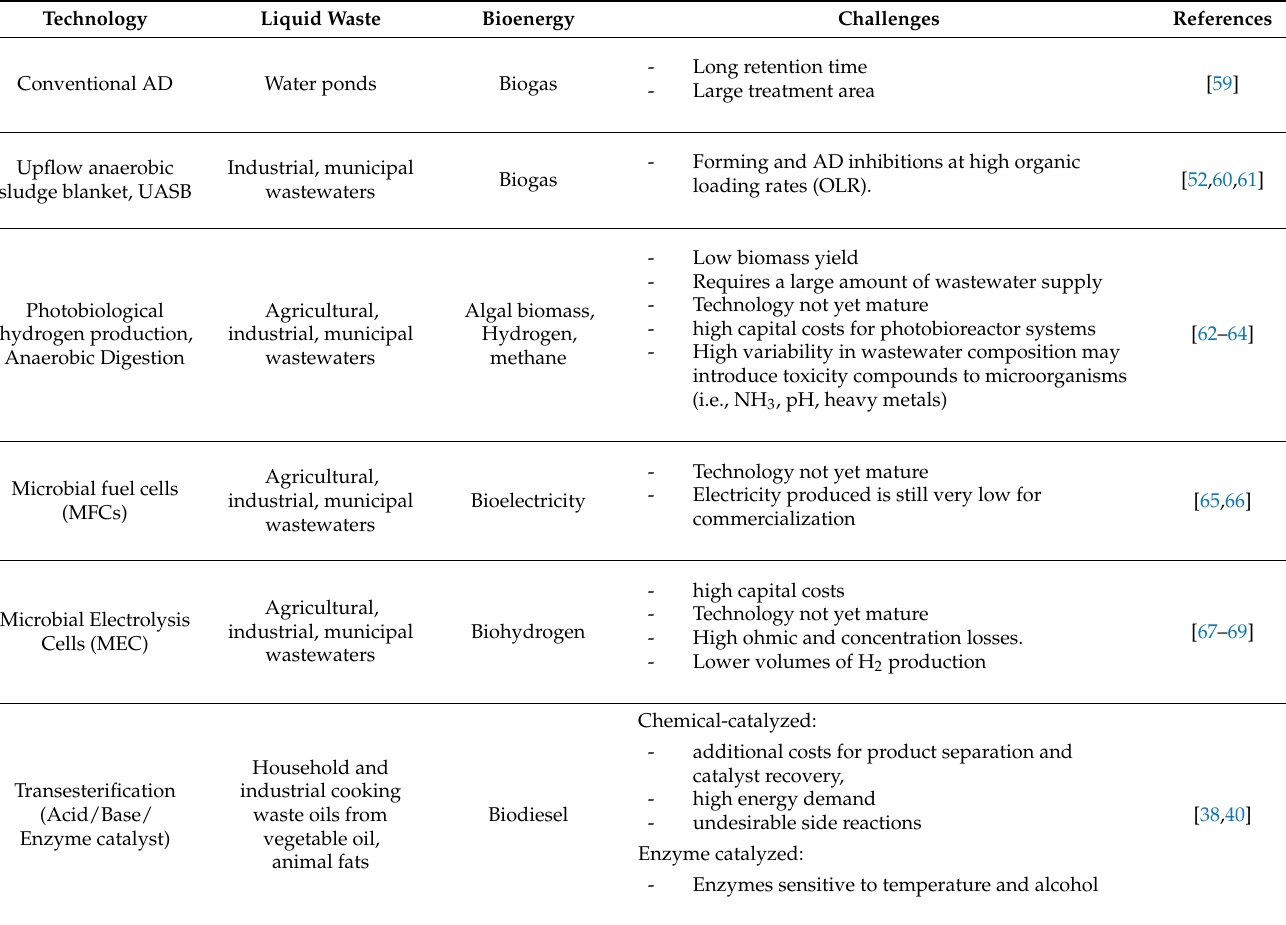
Table 1. Liquid biowaste to energy technologies, feedstock, and bioenergy